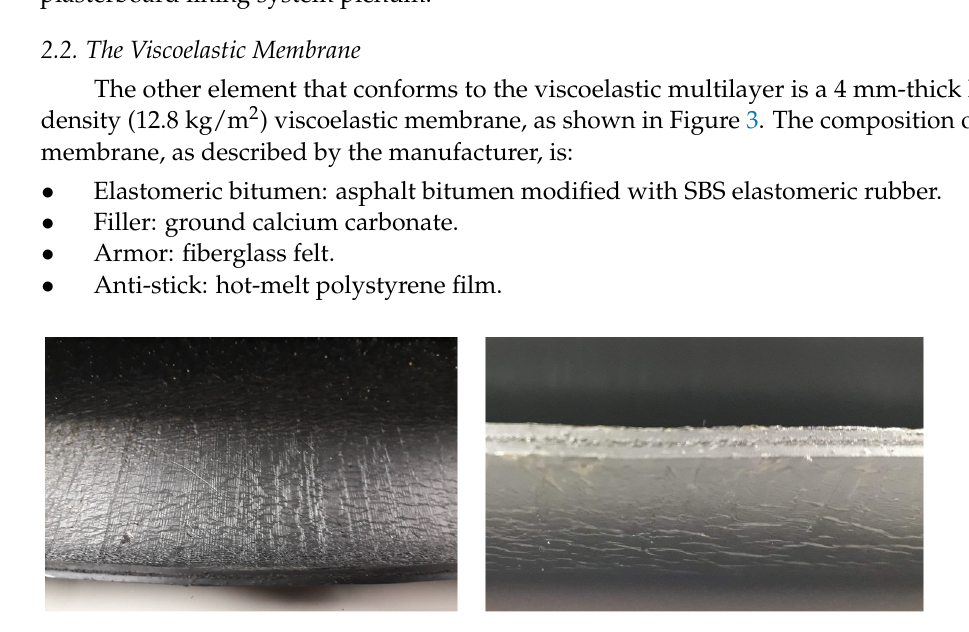
Figure 3. Materials: the viscoelastic membrane.